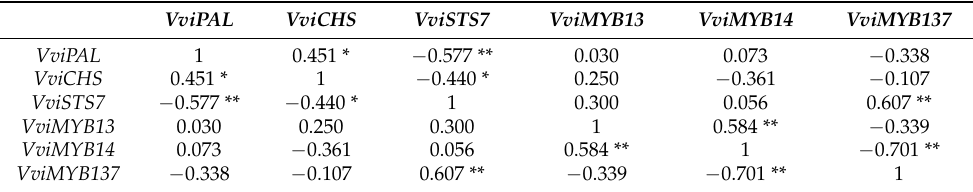
Table 2. Pearson correlation between VviPAL, VviCHS, VviSTS7, VviMYB13, VviMYB14 , and VviMYB137 from the skin of non-treated and ethanol-treated It 681–30 table grapes stored at low temperature and after the shelf-life